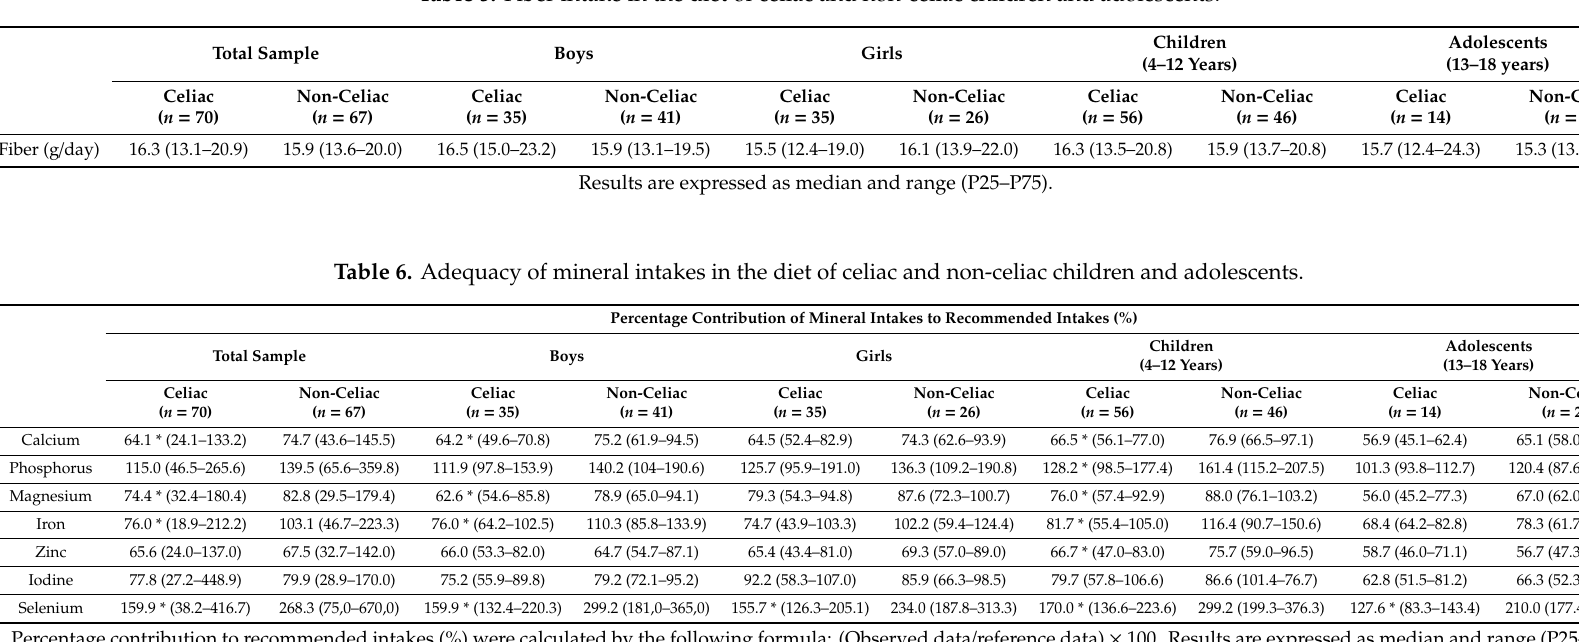
Table 5. Fiber intake in the diet of celiac and non-celiac children and adolescents.